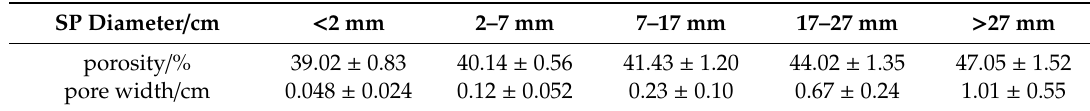
Table 1. Soil porosity and pore width.